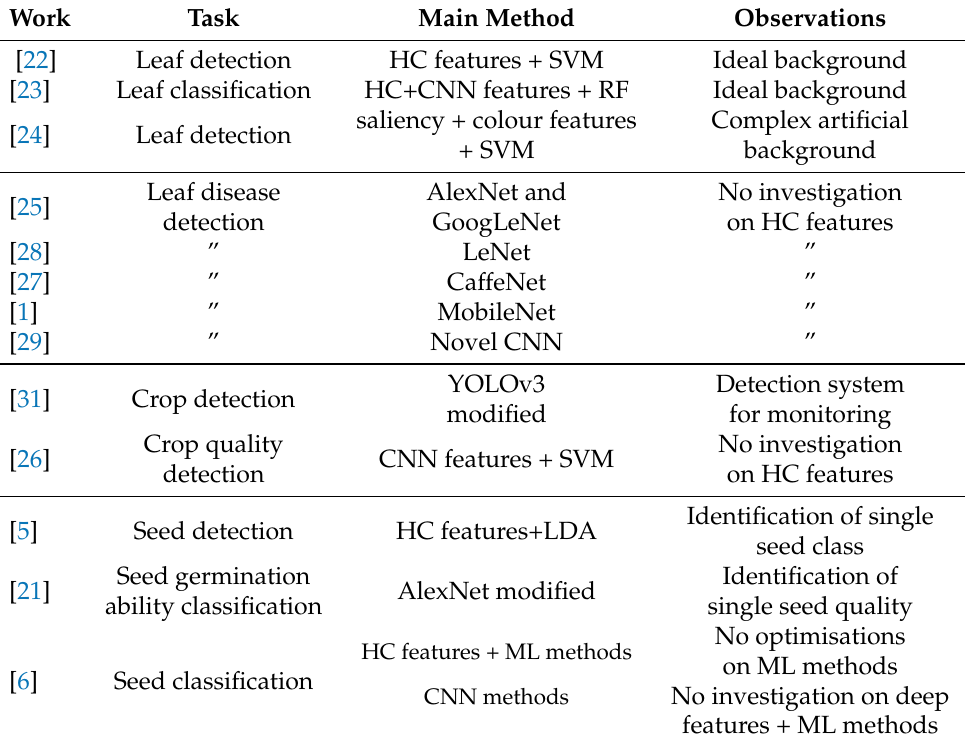
Table 2. Overview of existing works in this field with key insights from the proposed